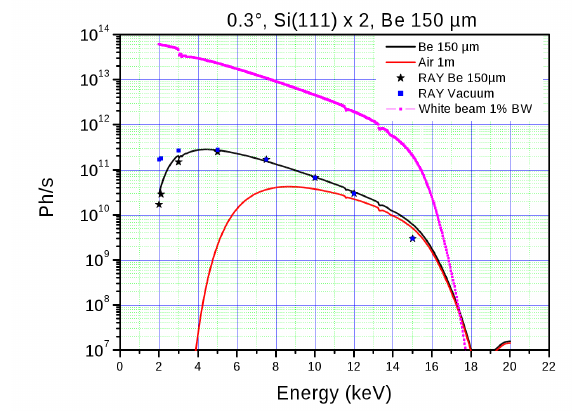
Figure 3: Comparison of the flux of the white and monochromatic beam in the focal